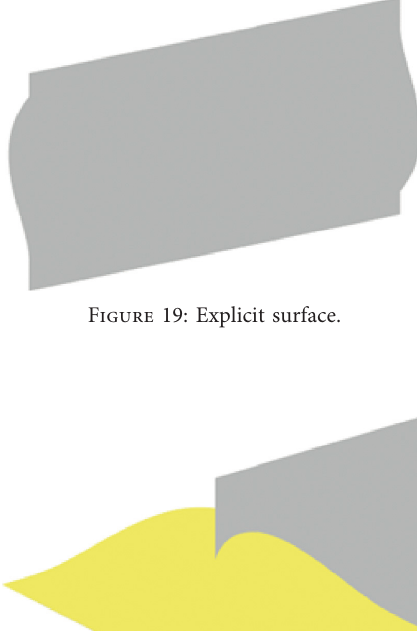
Figure 16: Cubic spline fitted for 2nd iteration of GA.